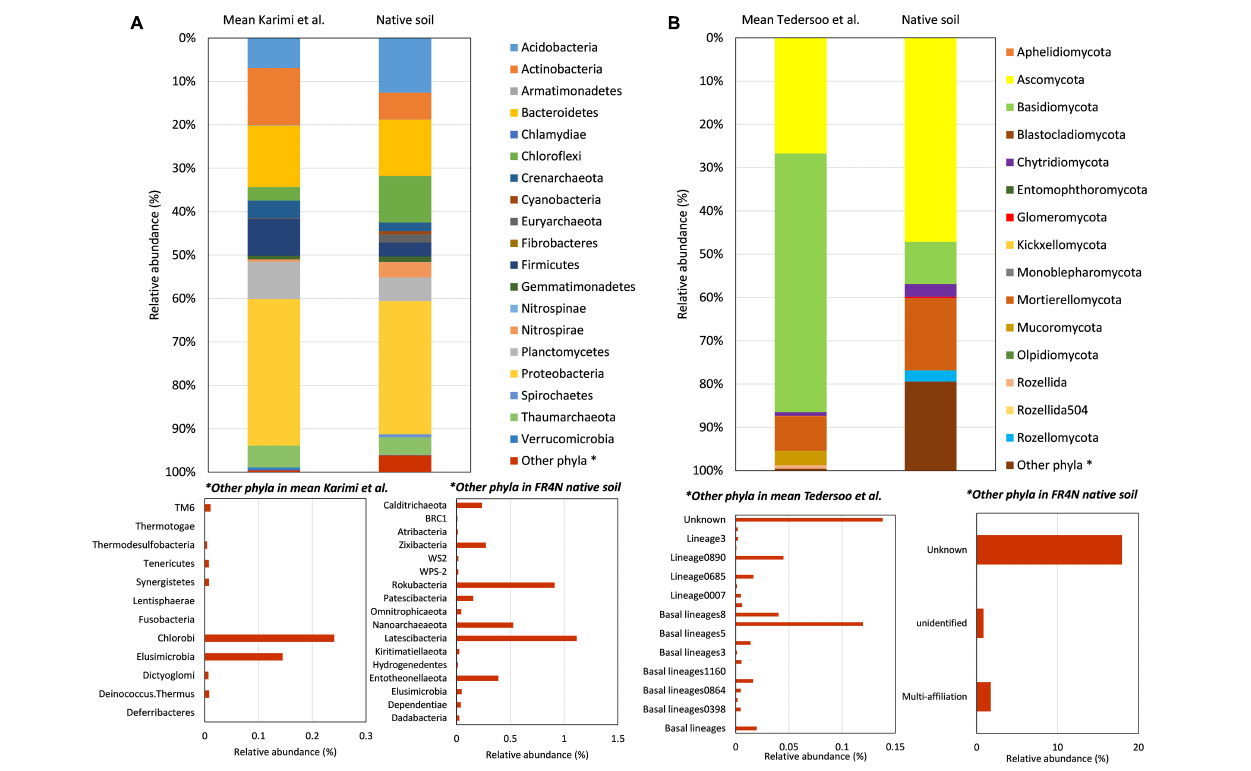
FIGURE 3 | Comparison of microbial diversity at the phylum level for (A) bacteria and archaea between FR4N soil and data from Karimi et al. (2018), and (B) fungal diversity between FR4N soil and data from Tedersoo et al. (2014). Data from Karimi et al. (2018) correspond to mean diversity in 2,173 soil samples from France and data from Tedersoo et al. (2014) correspond to mean values in a selection of 127 samples corresponding to representative couples of soil/climate that can be found in France (i.e., temperate coniferous forests, temperate deciduous forests, grassland, and shrubland and Mediterranean soils).